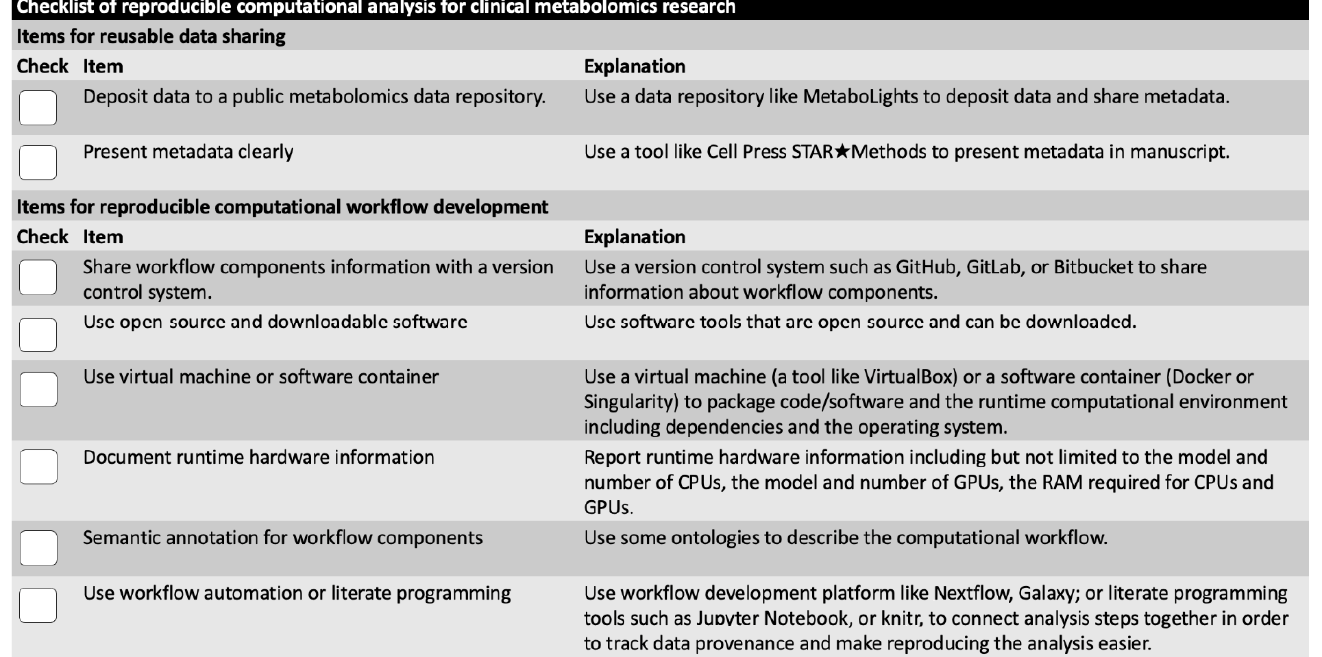
Figure 2. Checklist for computational reproducibility improvement of clinical metabolomics research. Eight items are included, which are categorized to reusable data sharing items and reproducible computational workflow items. All items are about actions that a researcher needs to take for reproducibility improvement. Detailed explanation and example resources are also included on right side of figure.